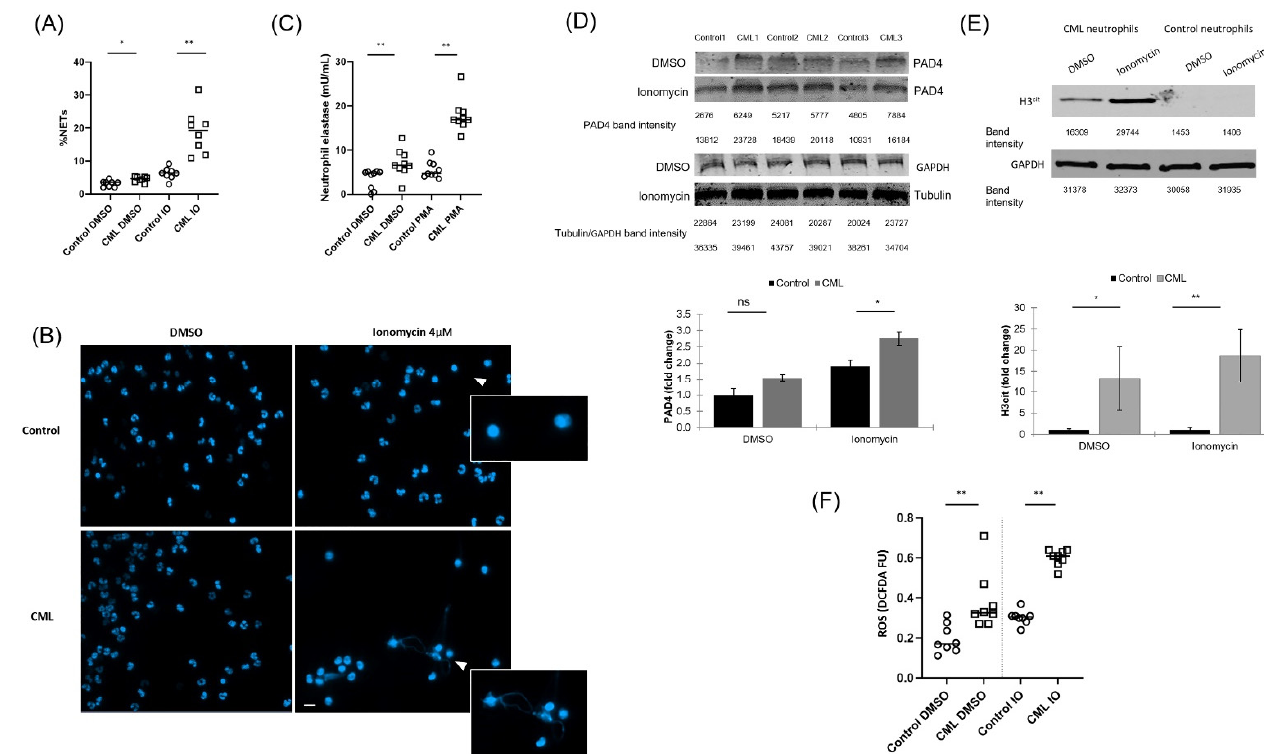
Figure 1. ( A ) Neutrophil extracellular trap (NET) formation in patients with newly diagnosed chronic myeloid leukemia (CML) compared to age- and gender-matched healthy controls when stimulated with 5 µM ionomycin (IO) or dimethyl sulfoxide (DMSO) for 2 h. n = 8 for each group. NET formation is presented as % neutrophils with morphologic changes characteristic of NET formation (see methods). * p < 0.05 ** p < 0.005. ( B ) Representative immuno-fluorescent (IF) images of neutrophils derived from patients with CML and controls after stimulation with 4 µM IO or DMSO for 2 h. 4 ′ ,6-Diamidino-2-phenylindole (DAPI) is shown in blue. White arrowheads denote NET- associated morphological changes. Scale bar, 50 µm. ( C ) NET formation expressed as the amount of NET-bound elastase in patients with newly diagnosed CML compared to healthy controls when stimulated with 100 µM phorbol 12-myristate 13-acetate (PMA) or DMSO for 4 h. n = 9 for each group. ** p < 0.005. Neutrophil lysates of patients with CML and controls blotted for ( D ) Peptidyl arginine deiminase 4 (PAD4) and ( E ) Citrullinated histone H3 (H3cit) expression after stimulation with 5µM IO or DMSO for 2.5 h. n = 3 for each group. * p < 0.05 ** p < 0.005. Complete blot analysis